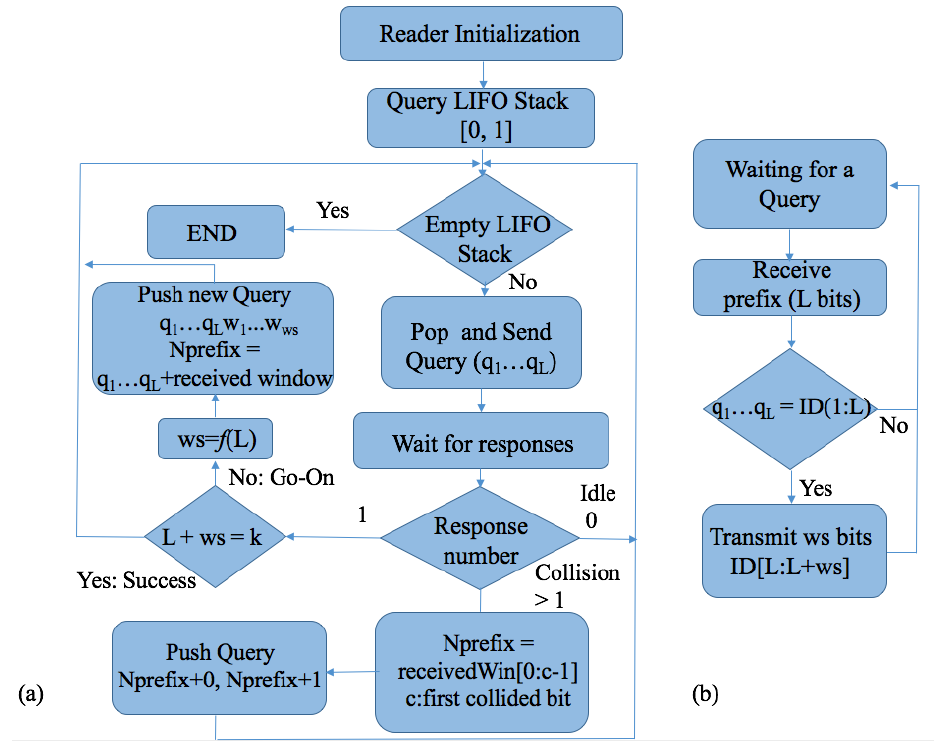
Figure 20. Flow chart of CwT protocol: ( a ) for reader; ( b ) for tags. Table 5. A comparison of tree-based protocols using